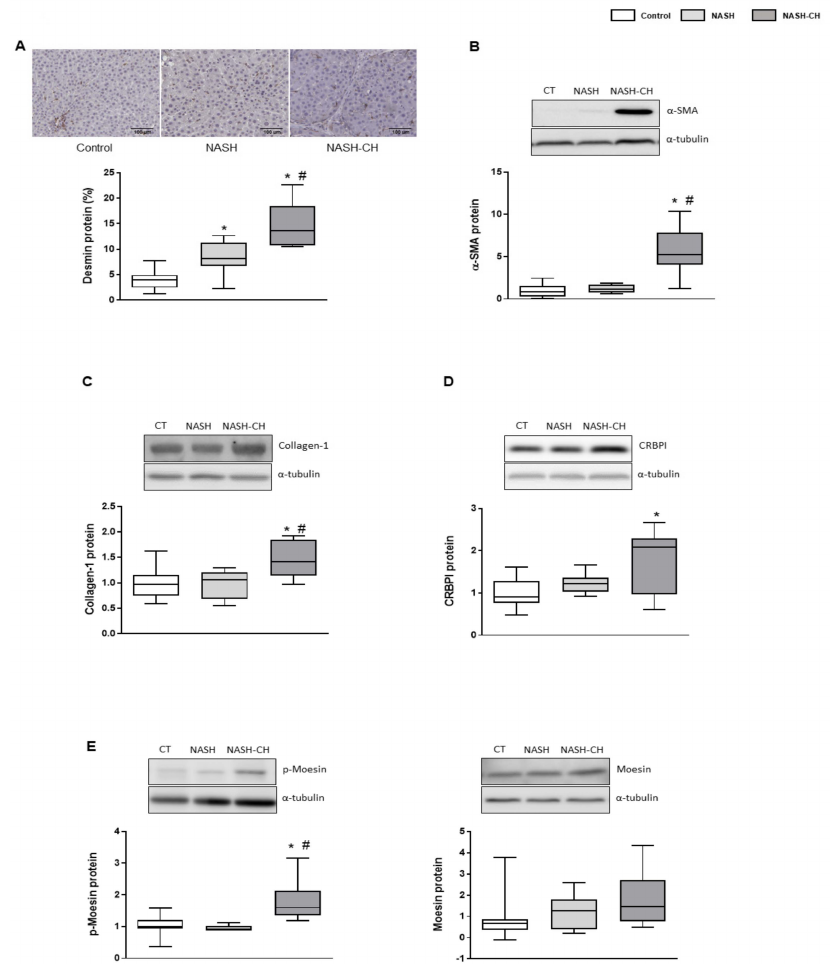
Figure 4. HSC phenotype in control and NASH rats. ( A ) Representative images of desmin immunohistochemistry in liver tissue and its quantification. ( B ) α -SMA protein expression in total liver tissue, normalized to α -tubulin, and corresponding quantification. ( C ) Collagen-1 α 1 protein expression in total liver tissue, normalized to α -tubulin. ( D ) CRBP1 protein expression in total liver tissue, normalized to α -tubulin. ( E ) p-moesin and moesin protein expression in total liver tissue, normalized to α -tubulin. Results represent mean ± SEM, * p < 0.05 vs. control group, # p < 0.05 vs. NASH group ( n = 6 rats per group). All images scale bar = 100 µ